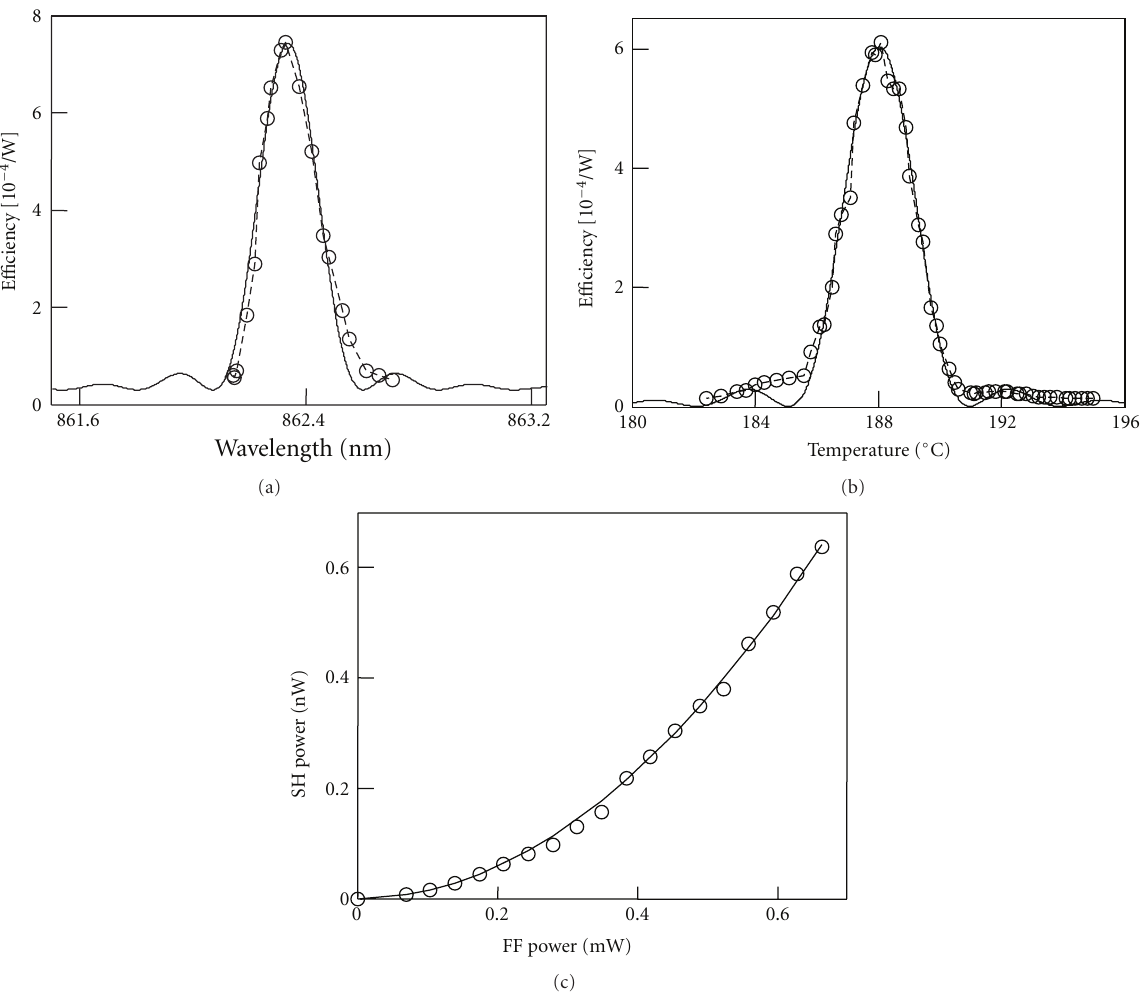
Figure 6: Normalized SHG conversion e ffi ciency versus (a) FF wavelength and (b) temperature for an input power of 0.7mW; (c) parabolic trend of the generated SH versus FF input power at the QPM resonant wavelength.